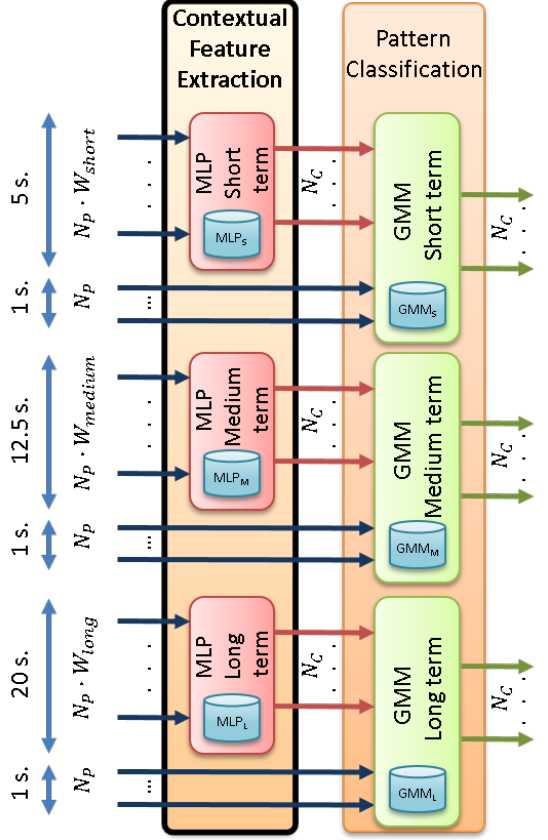
Figure 4. Detailed architecture of the contextual feature extraction module and its connection to the GMM-based pattern classification